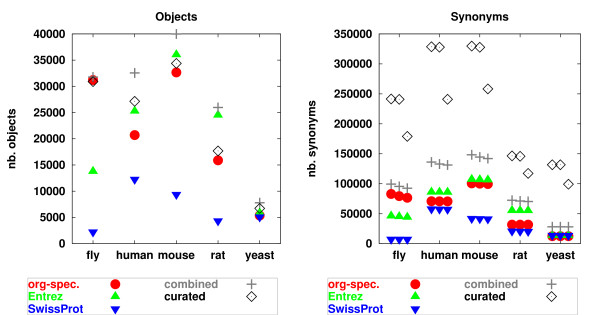
Size of gene name dictionaries. Number of objects (left plot) and synonyms (right plot) for gene name dictionaries compiled from different data sources (organism-specific database: Yeast: Saccharomyces Genome Database, Fly: FlyBase, Mouse: Mouse Genome Informatics, Rat: Rat Genome Database, Human: HUGO; 'combined' is the merged dictionary from the organism-specific database, Swiss-Prot and Entrez Gene; 'curated' is additionally expanded and pruned). In the right plot, the three marks for each dictionary correspond to the three definitions of equivalence: exact, mixed, and normalized, respectively, from left to right. For details see section 'Compilation of gene name dictionaries'.